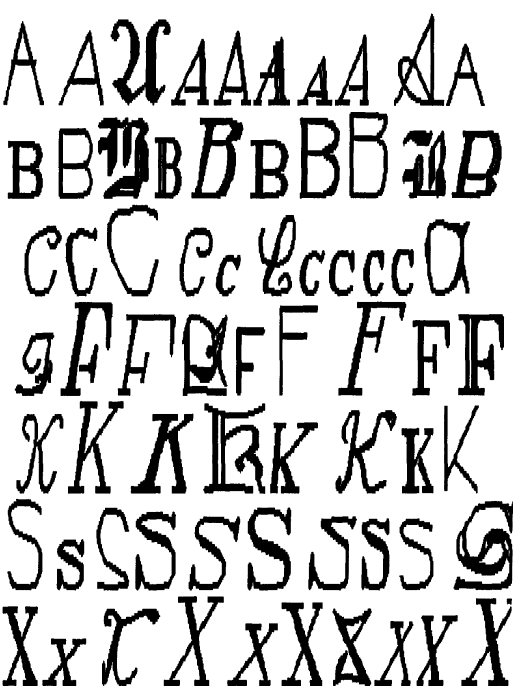
Figure 3. Examples of letter recognition open dataset.